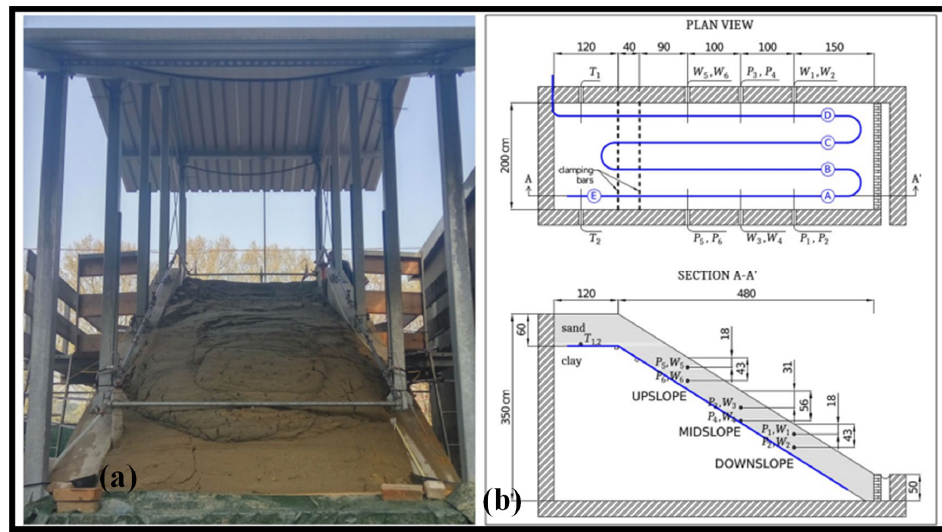
Figure 14. Landslide monitoring, ( a ) the large-scale physical replica underwent the and slide during testing [187], ( b ) views from the top and sides of the instrumented fume show the clamping bars as vertical dashed lines in the top image [187].